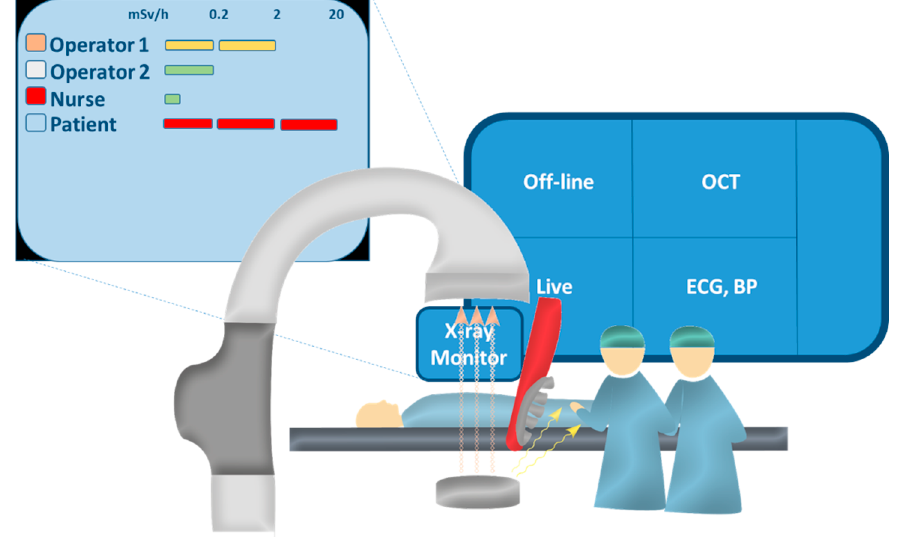
Figure 1. Real-time measurement of dosimetry.